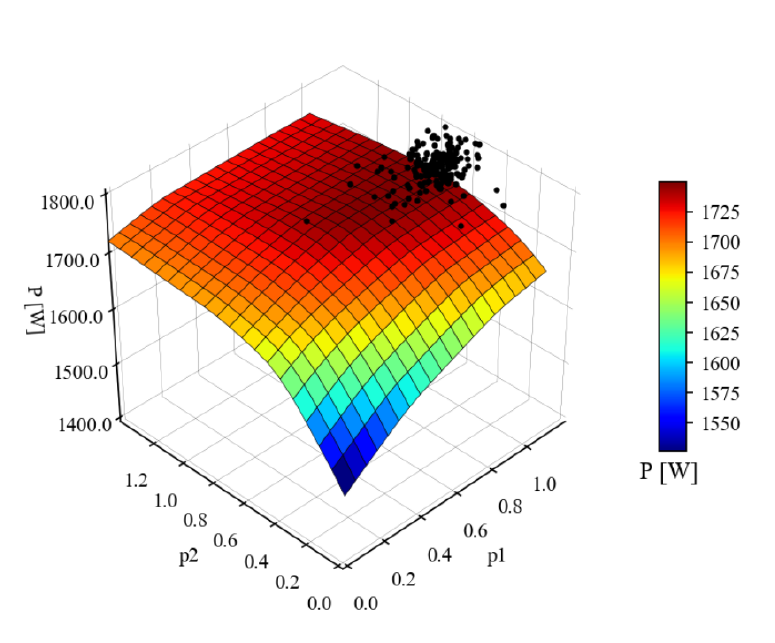
Figure 28. PSA finds a maximum on the response surface visualized in two